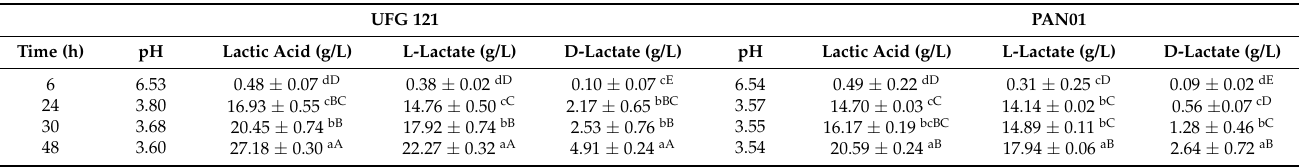
Table 3. pH and lactic acid (L- and D-enantiomers) production by UFG 121 and PAN01 strains monitored during 48 h of growth in MRS